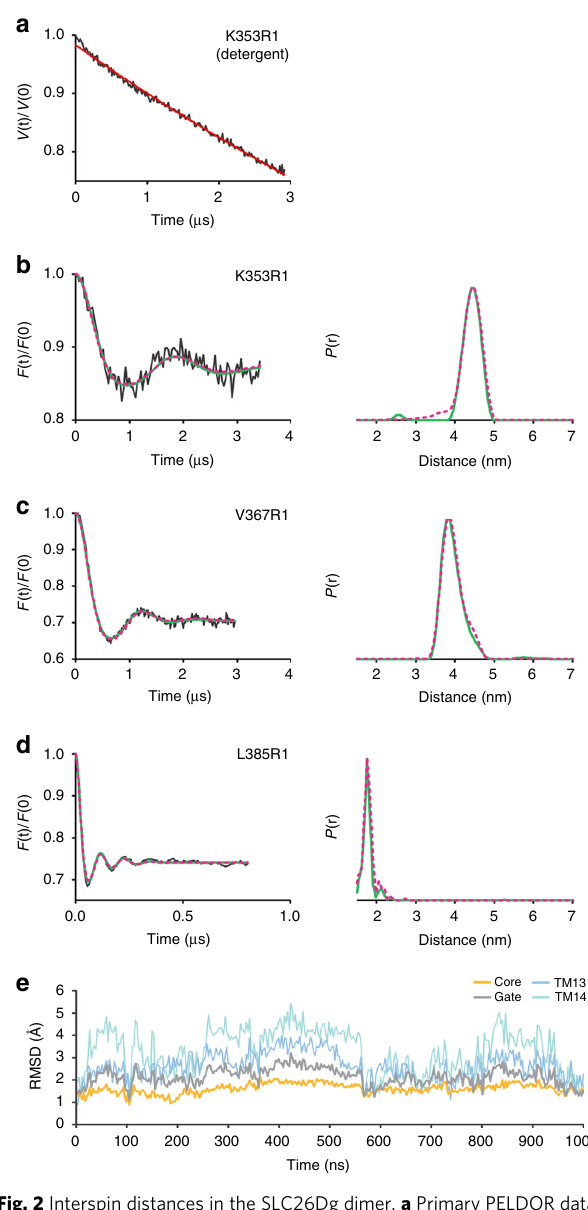
Fig. 2 Interspin distances in the SLC26Dg dimer. a Primary PELDOR data of detergent-solubilized K353R1. b – d Left panels: background-corrected PELDOR time traces for membrane-reconstituted K353R1, V367R1, and L385R1 (black traces), overlaid with the fi t from Tikhonov regularization (green), and forward-calculated PELDOR time traces from BioEn spin-label rotamer re fi nement of the MD simulation model (magenta, dashed; θ = 10). Right panels: distance distributions obtained by Tikhonov regularization (green), overlaid with the distance distributions resulting from BioEn analysis of the MD simulation model (magenta, dashed). Original PELDOR data in Supplementary Fig. 2. e C α -atom root mean squared distance (RMSD) values of the core, gate, TM13, and 14 relative to the monomer crystal structure as a function of MD time (1 μ s)